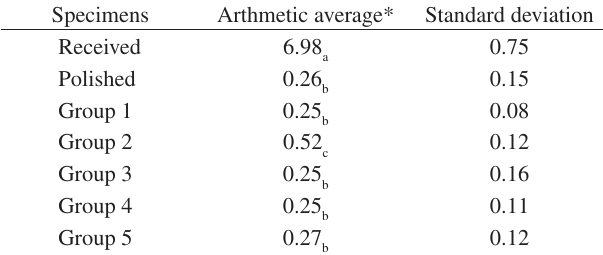
Table 2. Arithmetic average and standard deviation of the values of rugosity obtained from the specimens: as received, polished and in different attack